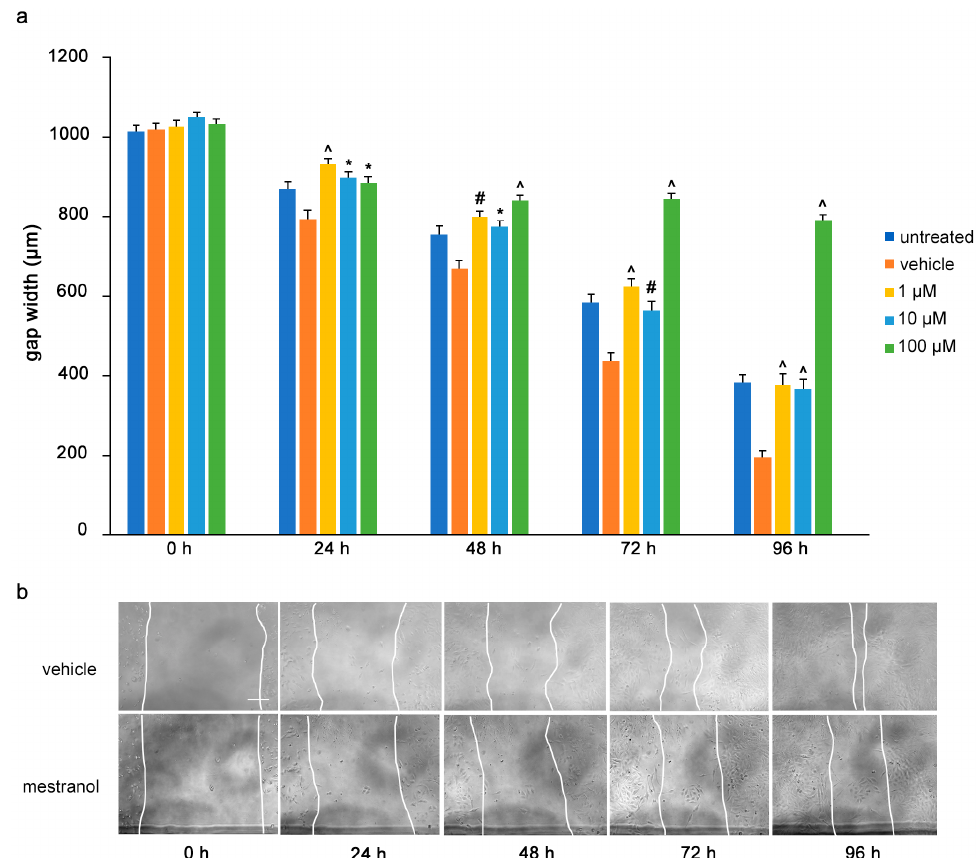
Figure 5. Mestranol inhibits migration of U251 cells. U251 cells were seeded in 96-well plates. After 24 h, monolayers were scratched, immediately imaged, and then treated with different concentrations of mestranol (1, 10 and 100 μ M). Cells were imaged every 24 h up to 96 h. ( a ) Graph shows the gap width ( μ m) of untreated cells, vehicle-treated cells and cells treated with vehicle or mestranol. Two images were taken per well and values for each condition were averaged. Error bars show mean + SEM from 5 independent experiments. * p < 0.05, # p < 0.01, ^ p < 0.001 as determined by one- way ANOVA with Tukey’s post hoc test. ( b ) Representative images of 100 μ M mestranol- and ve- hicle-treated cells. Scale bar for all images, 200 μ m in panel vehicle, 0 h.